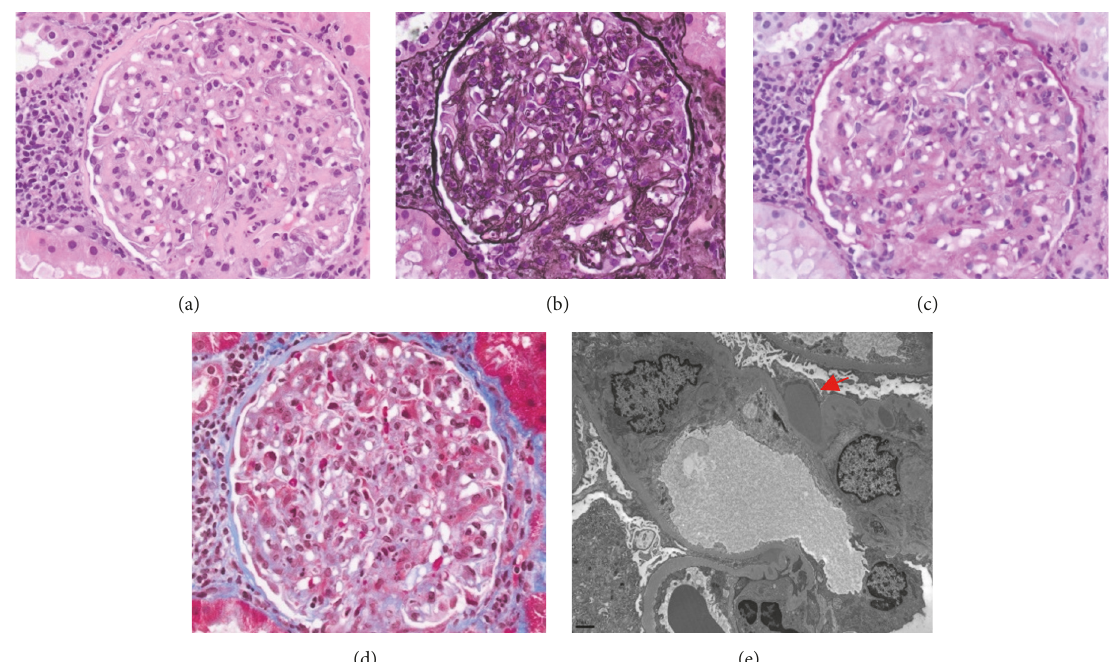
Figure 1: (a) Light microscopy. Hematoxylin and stain. Significant endocapillary proliferation with neutrophils and swollen endothelial cells. (b) Jones stain with occasional double contour. No evidence of significant crescents noted. (c) Periodic acid-Schiff stain revealed mild mixed interstitial inflammation with lymphocytes, plasma cells, and neutrophils. (d) Trichrome stain with focal mild interstitial fibrosis and tubular atrophy. (e) Electron microscopy. Large subepithelial electron dense deposits (arrow) consistent with